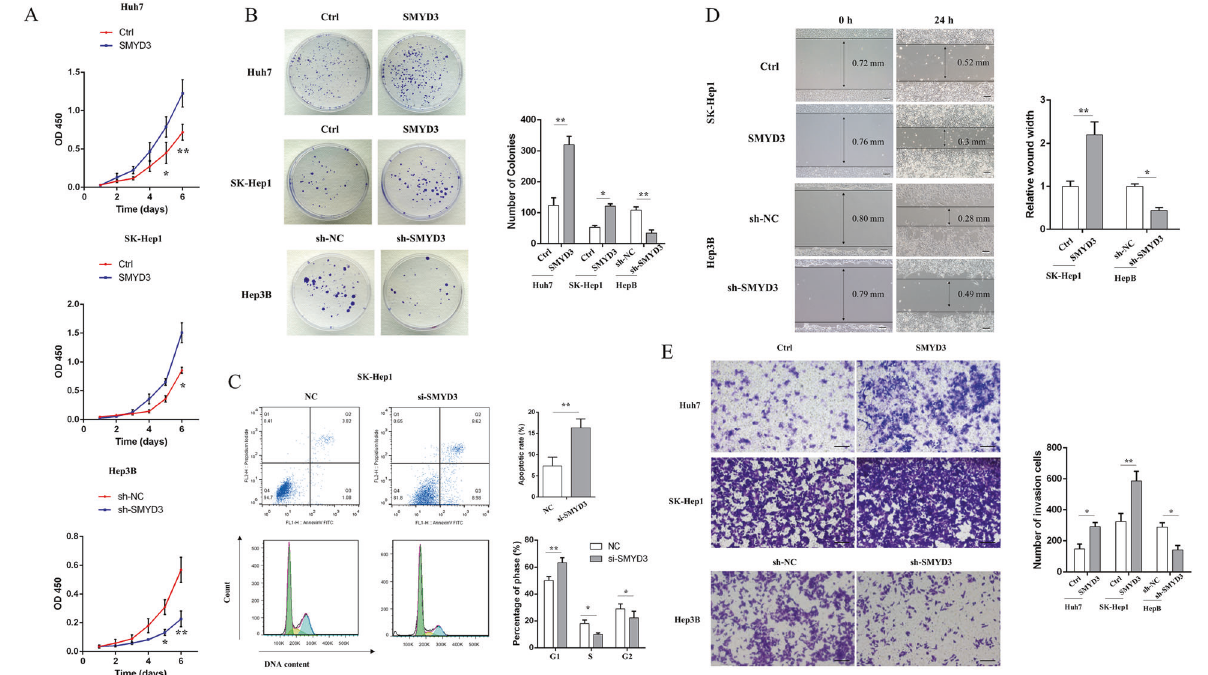
Fig. 2 SMYD3 promoted the proliferation, colony formation, and migration of HCC cells. CCK8 ( A ), colony formation ( B ), cell cycle and apoptosis analysis using fl ow cytometry ( C ), wound-healing ( D ), and transwell assays ( E ) were performed to evaluate cell proliferation and migration in response to the overexpression or knockdown of SMYD3 in Huh7, SK-Hep1, and Hep3B cells. Bar = 100 μ m. Data are presented as the means ± SD of three separate experiments, each performed in triplicate. * P < 0.05; ** P <